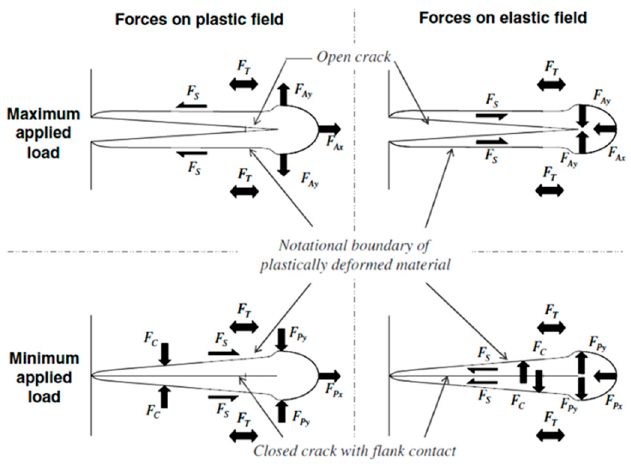
Figure 1. Schematic diagram illustrating the forces acting at the interface of the plastic zone and the surrounding elastic material [11].